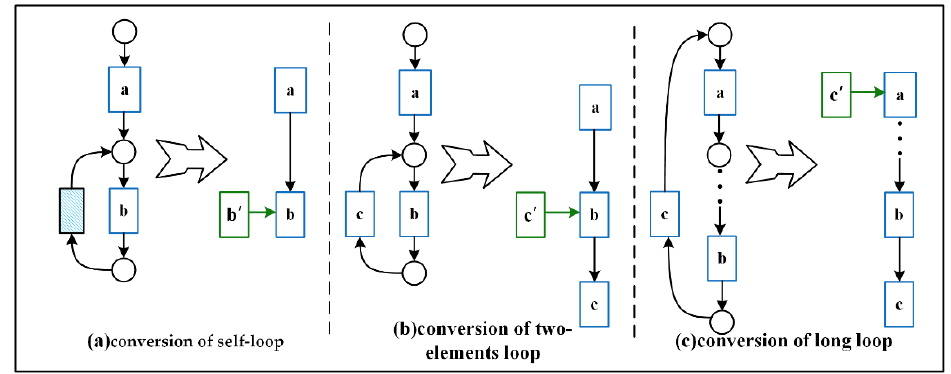
Figure 6. Disassembling the loop structure of Petri